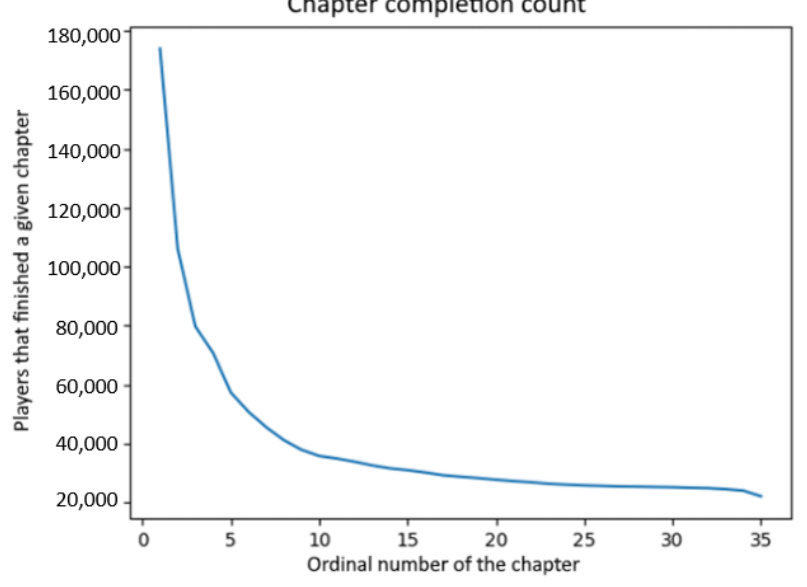
Figure 5. Player churn distribution by